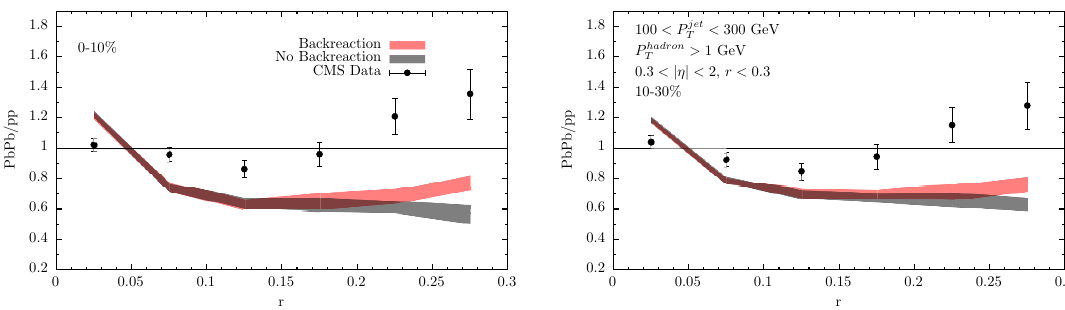
Figure 10 . Ratio of the jet shape in PbPb collisions with p s = 2 : 76 ATeV with 0-10% centrality (left) and 10-30% centrality (right) to the jet shape in proton-proton collisions. The two colored bands show the results of our hybrid model calculation with no broadening, with both jets and background hadronized, and with our background subtraction procedure for high- p T jets applied. In the calculation shown as the red band we include the e(cid:11)ects of backreaction, namely the particles coming from a wake in the medium. We compare our calculation with and without backreaction